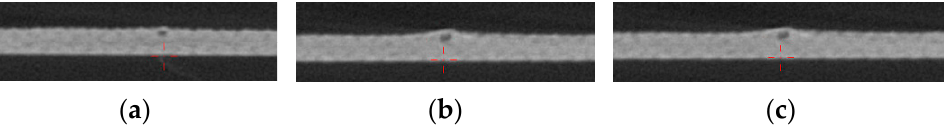
Figure 14. Non-destructive testing using CT: ( a ) specimen T300-18 (zoom = 150%), ( b ) specimen 70A-8 (zoom = 150%), ( c ) specimen 95A-12 (zoom = 150%).